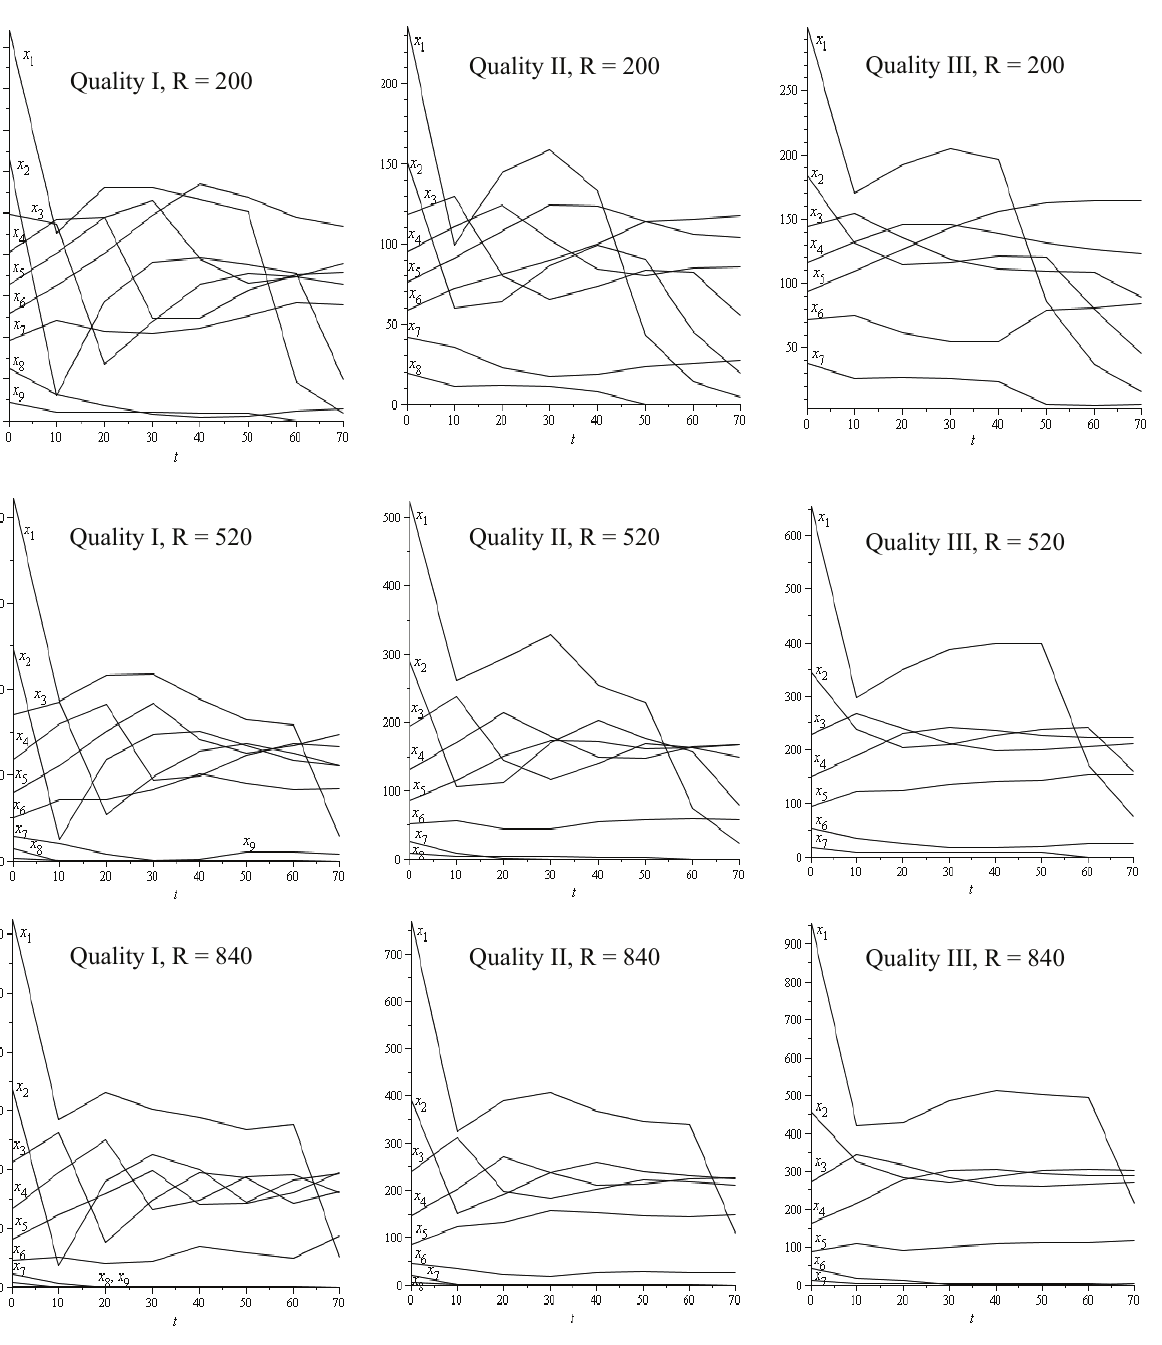
Figure 3. Population dynamics, x , to maximize the NPV function throughout a harvest k (cid:28) 1 cycle of 70 years for G = 24 m 2 ha and i = 3% (left: Quality I; middle: Quality II; right: Quality III; first row: R = 200 stems/ha; second row: R = 520 stems/ha; third row: R = 840 stems/ha). The initial conditions (intercepts on ordinate axis) are defined by the stable diameter